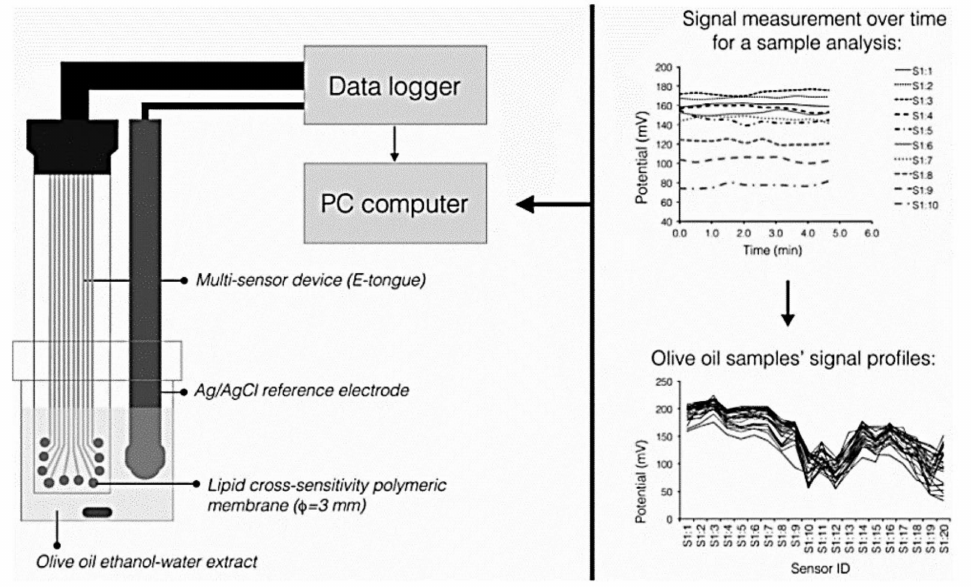
Figure 7. EVOO analysis scheme: electronic tongue (left); potentiometric signals registered for a sample analysed and the profile of the signals registered for the samples analysed (right). Published from [127] with the permission of the